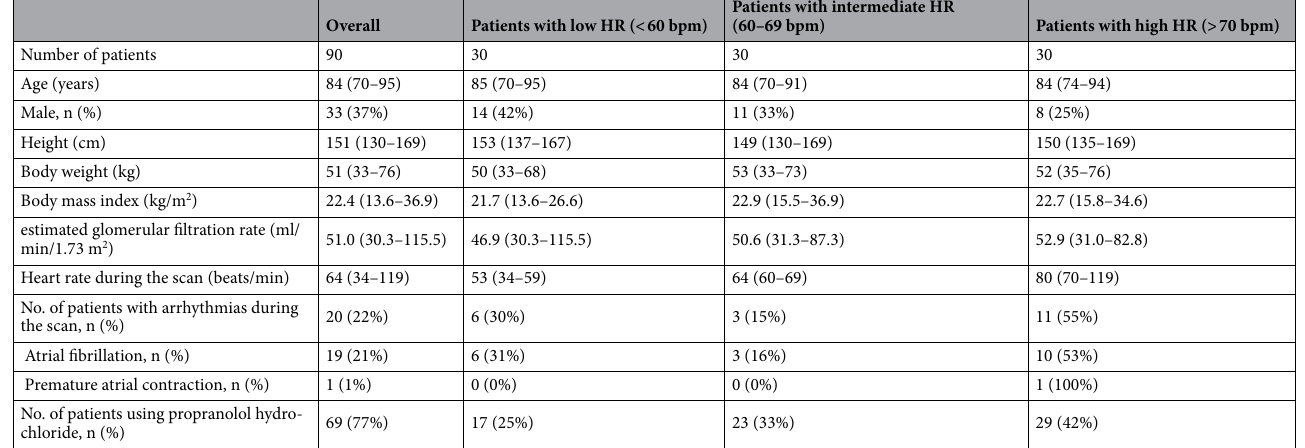
Table 2. Patient characteristics. Values are the median (range) or the number of patients (%). Propranolol hydrochloride was administered to reduce the heart rate before imaging.